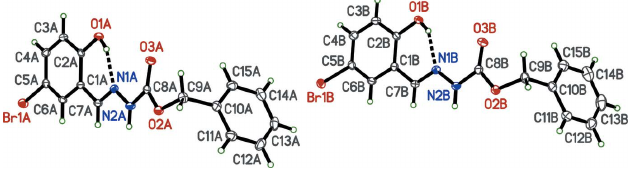
Figure 2 An ellipsoid plot of the asymmetric unit of II , showing the intramolecular hydrogen bonds (O1 A —H1 AO (cid:2)(cid:2)(cid:2) N1 A and O1 B —H1 BO (cid:2)(cid:2)(cid:2) N1 B ) as dashed lines.